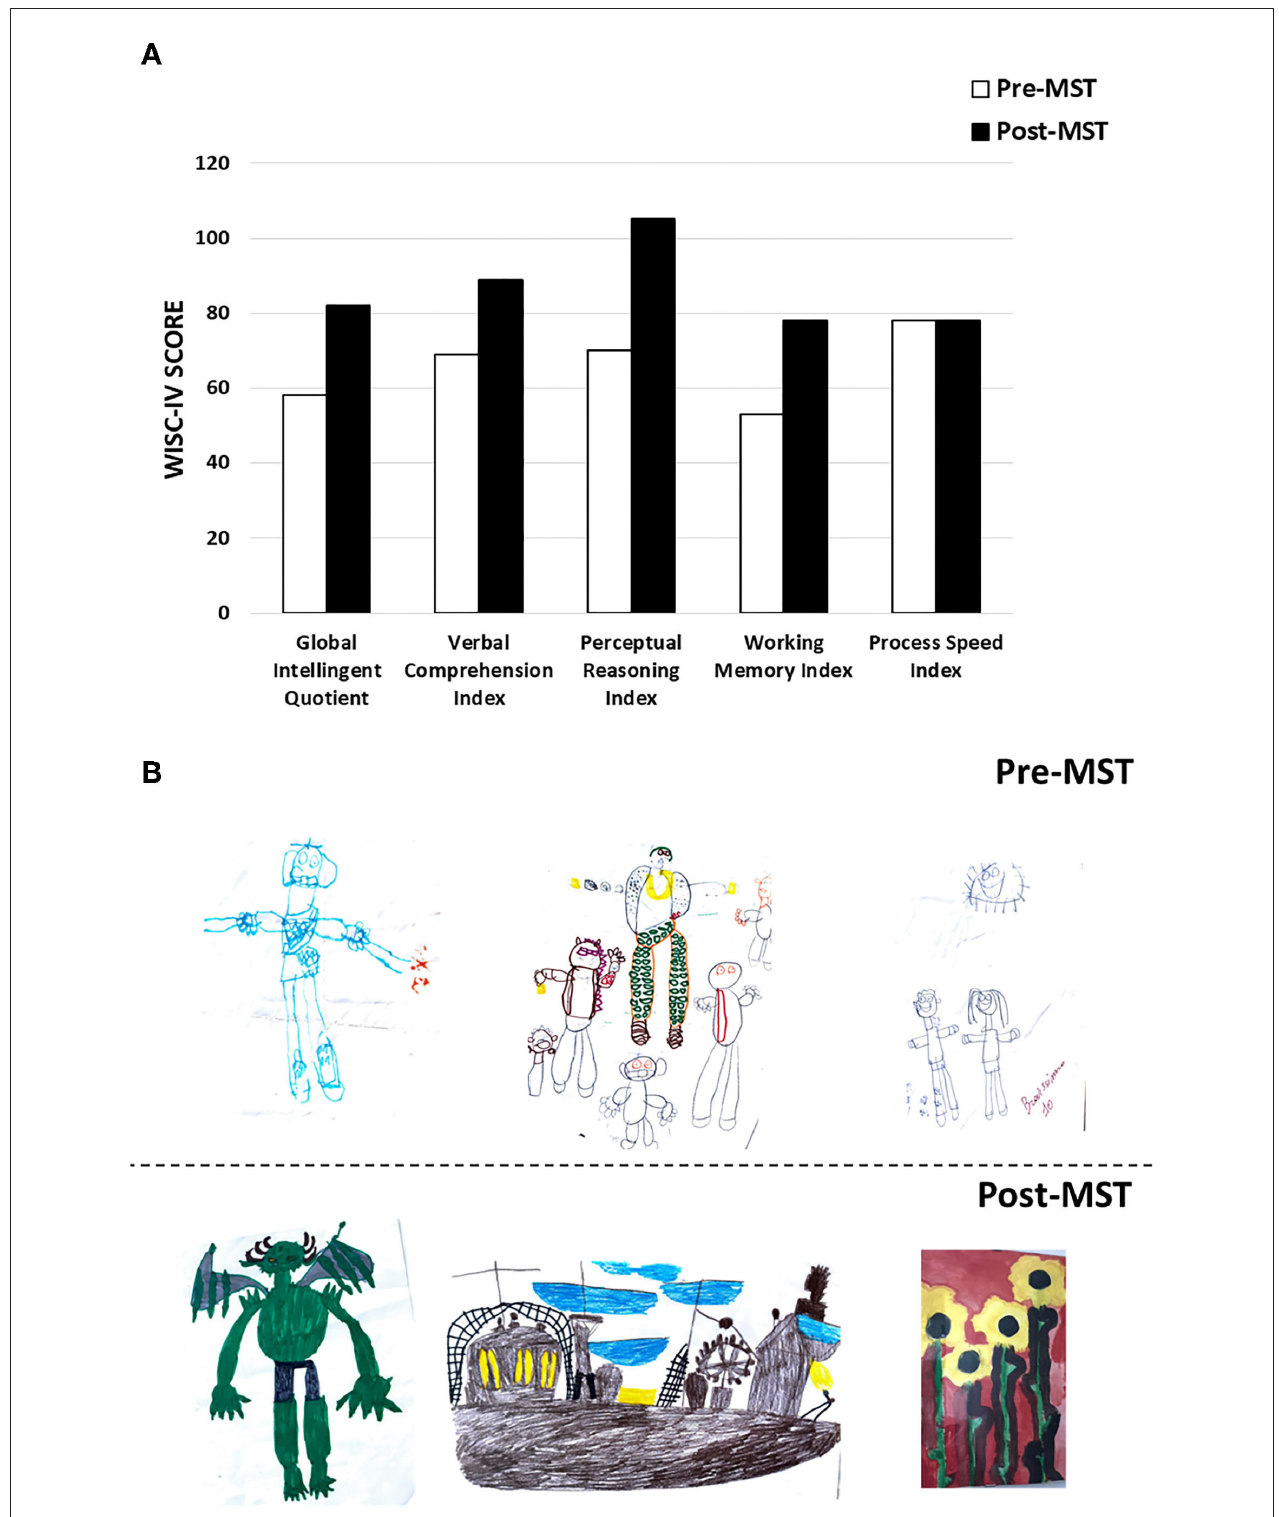
FIGURE 3 | Two “very much improved” patients: (A) cognitive profile of a 13 year-old boy with ID before and after 6 months of MST, assessed using the WISC-IV; (B) drawings by a 12 year-old boy with mild ASD before and after 3 months of MST.